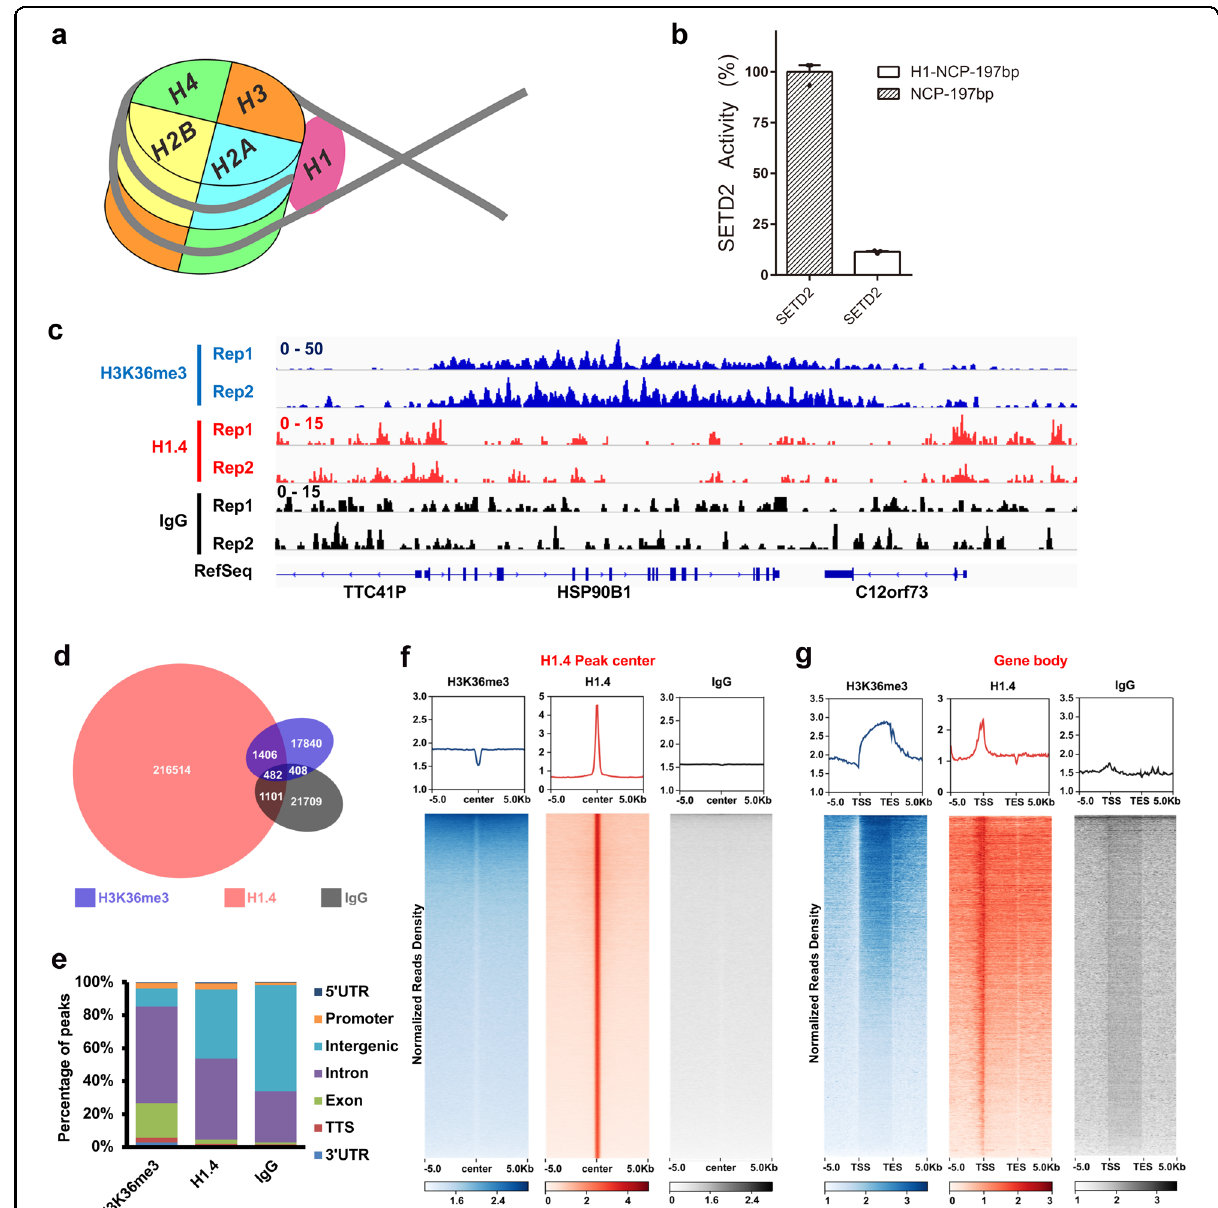
Fig. 3 Histone H1 represses the deposition of H3K36me3 by SETD2. a Schematic drawing of the nucleosome bound with a linker histone H1. b HMT assays performed with SETD2 toward the 197-bp nucleosomes bound with histone H1.4. The input of the HMT reactions is shown in Supplementary Fig. S5a. c Integrative Genomics Viewer (IGV) tracks representing the distributions of H3K36me3, H1.4 and IgG ChIP-Seq results with two replicates. Rep1, replicate 1, Rep2, replicate 2. d Venn diagram illustration showing the overlap of H3K36me3, H1.4 and IgG peaks. The peaks in independent replicates were combined. e The percentages of H3K36me3, H1.4 and IgG peaks in different genomic elements. ChIP-Seq results in independent replicates were combined. The distributions were analyzed by HOMER with default parameters. f The enrichments of H3K36me3, H1.4 and IgG ChIP-Seq results at H1.4 peak regions. A 100-bp sliding window was used to scan 10-kb regions surrounding the peak center. Heatmaps illustrating ChIP-Seq read densities from 5kb upstream to 5 kb downstream of the peak regions (in rows) were shown on a per-peak basis (in columns). g The distribution pro fi les of normalized H3K36me3, H1.4 and IgG read density from 5 kb upstream of the TSS to 5kb downstream of the